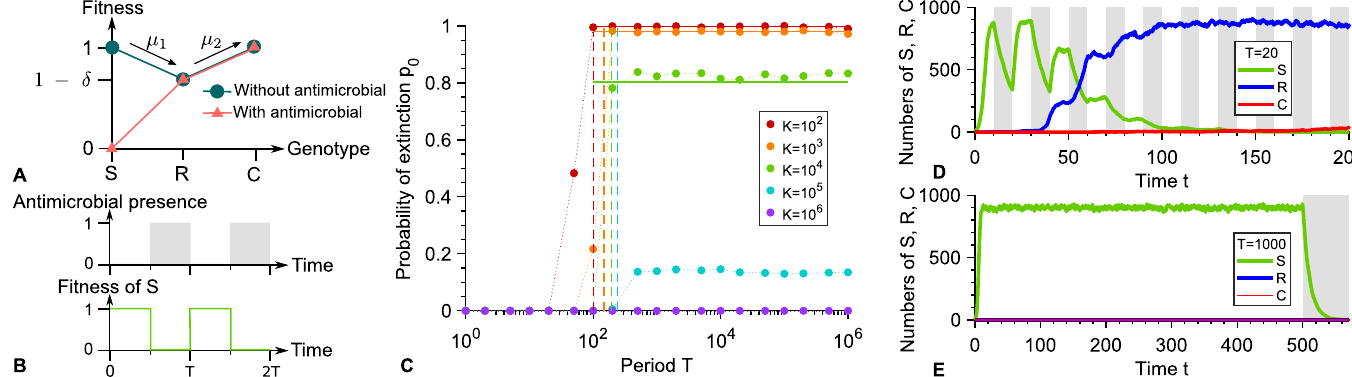
Fig 1. Periodic presence of a perfect biostatic antimicrobial. A: Microbial fitness versus genotype with and without antimicrobial. Genotypes are the following: S: sensitive; R: resistant; C: resistant-compensated. δ represents the fitness cost of resistance. B: Periodic presence of antimicrobial (gray: presence, white: absence), and impact on the fitness of S microorganisms. C: Probability p 0 that the microbial population goes extinct before resistance gets established versus alternation period T , for various carrying capacities K . Markers: simulation results, with probabilities estimated over 10 2 − 10 3 realizations. Horizontal solid lines: analytical predictions from Eq 1. Dashed lines: T /2 = τ S . D and E: Numbers of S, R and C microorganisms versus time in example simulation runs for K = 1000, with T = 20 and T = 1000 respectively. In D , resistance takes over, while in E , extinction occurs shortly after antimicrobial is first added. Phases without (resp. with) antimicrobial are shaded in white (resp. gray). Parameter values: f S = 1 without antimicrobial, f 0 ¼ 0 with antimicrobial, f R = 0.9, f C = 1, g S = g R = g C = 0.1, μ 1 = 10 − 5 and μ 2 = 10 − 3 . All simulations start with 10 S S microorganisms.